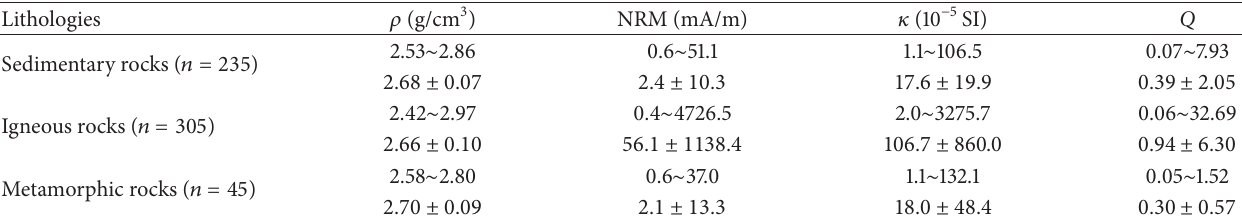
Table 5: Statistical results of 𝜌 , 𝜅 , NRM, and Q values of rocks with three major lithologies. Lithologies Sedimentary rocks ( 𝑛 = 235